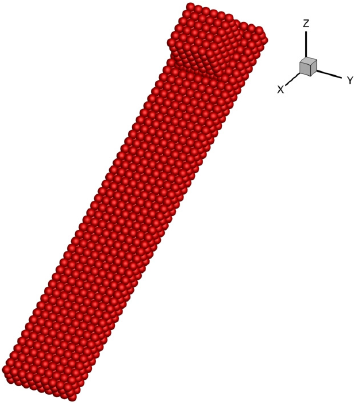
Figure 4. Initial SPH calculation model for a block sliding along a slope.